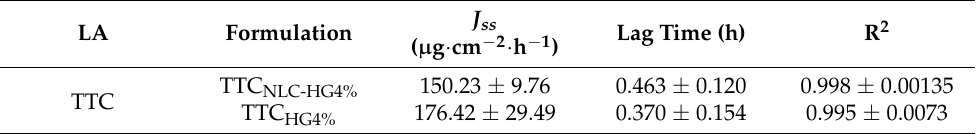
Figure 3. Profiles for permeation of the tetracaine-loaded formulations (TTC NLC-HG4% and TTC HG4% ) across the porcine nasal mucosa (mean ± SE, n = 5). Linear regression analysis between curves: p < 0.0001. Table 4. Mean (±SD) values of the steady-state flux ( J ss ) and lag time for permeation of tetracaine from TTC HG and TTC NLC-HG across the nasal mucosa.